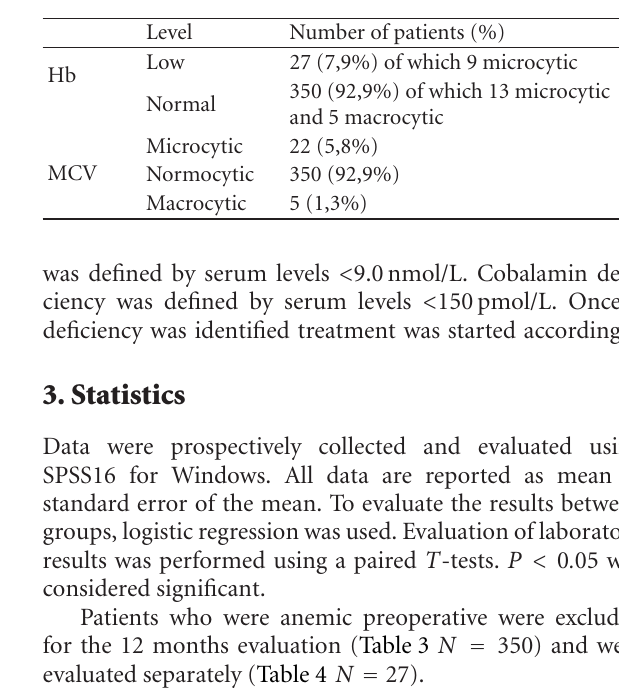
Table 1: Demographics. Table 2: Laboratory outcomes before